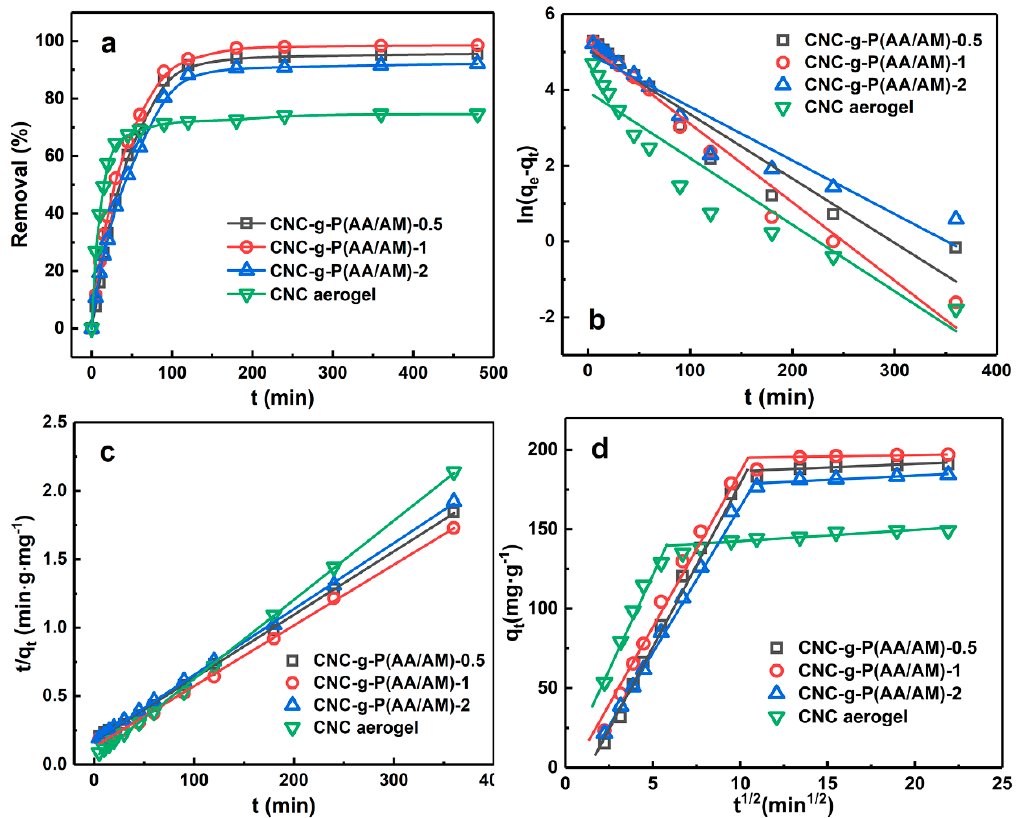
Figure 5. Kinetic studies of Pb(II) adsorption by the CNC-g-P(AA/AM)-0.5, CNC-g-P(AA/AM)-1, CNC-g-P(AA/AM)-2, and CNC aerogels (C 0 = 200 mg L − 1 ). ( a ) Effect of contact time, ( b ) the pseudo-first-order, ( c ) the pseudo-second-order, and ( d ) intra-particle diffusion models.